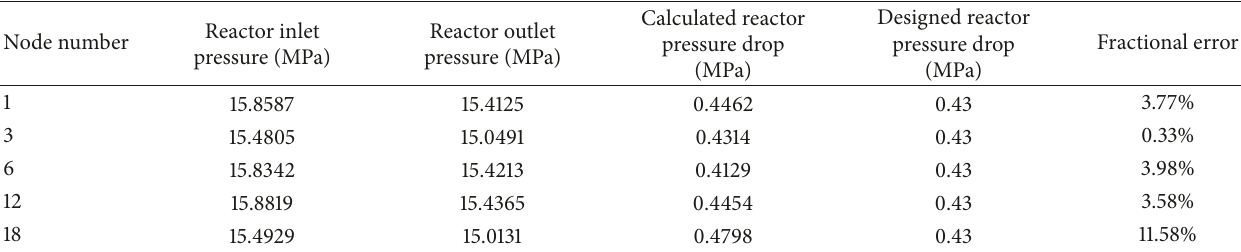
Table 13: The influence of pressurizer node number on the reactor pressure drop.